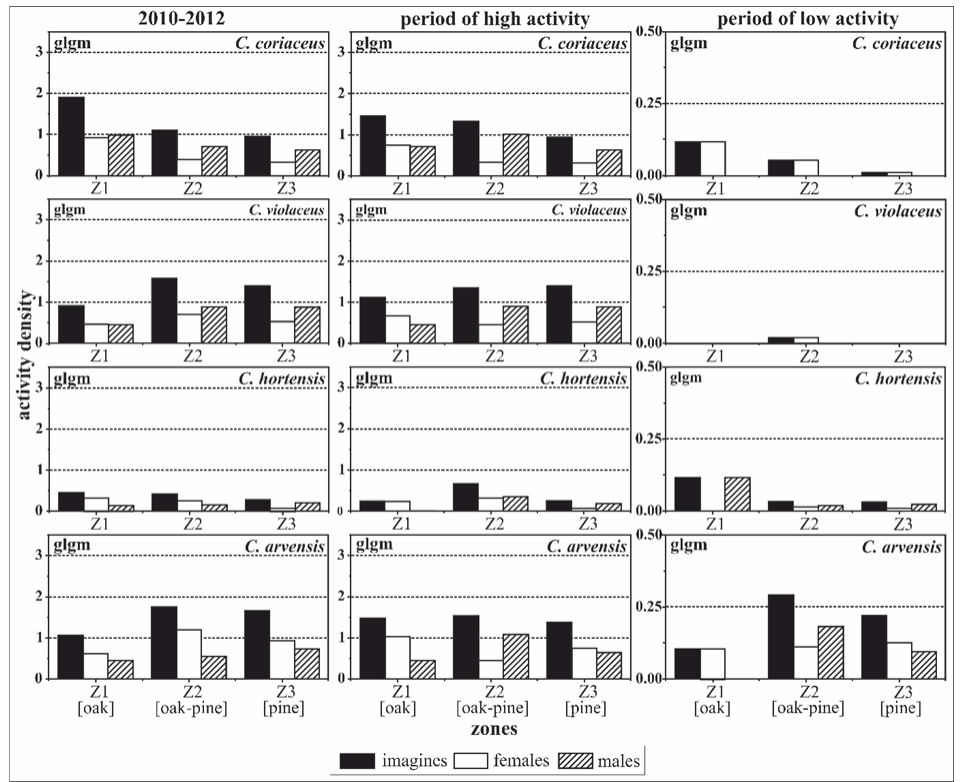
Figure 6. Differences in spatial distribution patterns between the females of the four observed Carabus species ( C. coriaceus , C. violaceus , C. hortensis , C. arvensis ). The results of the generalised linear geostatistical model (glgm) address effects of zoning and species simultaneously for different activity periods (high activity period: May to September, low activity period: October to April).